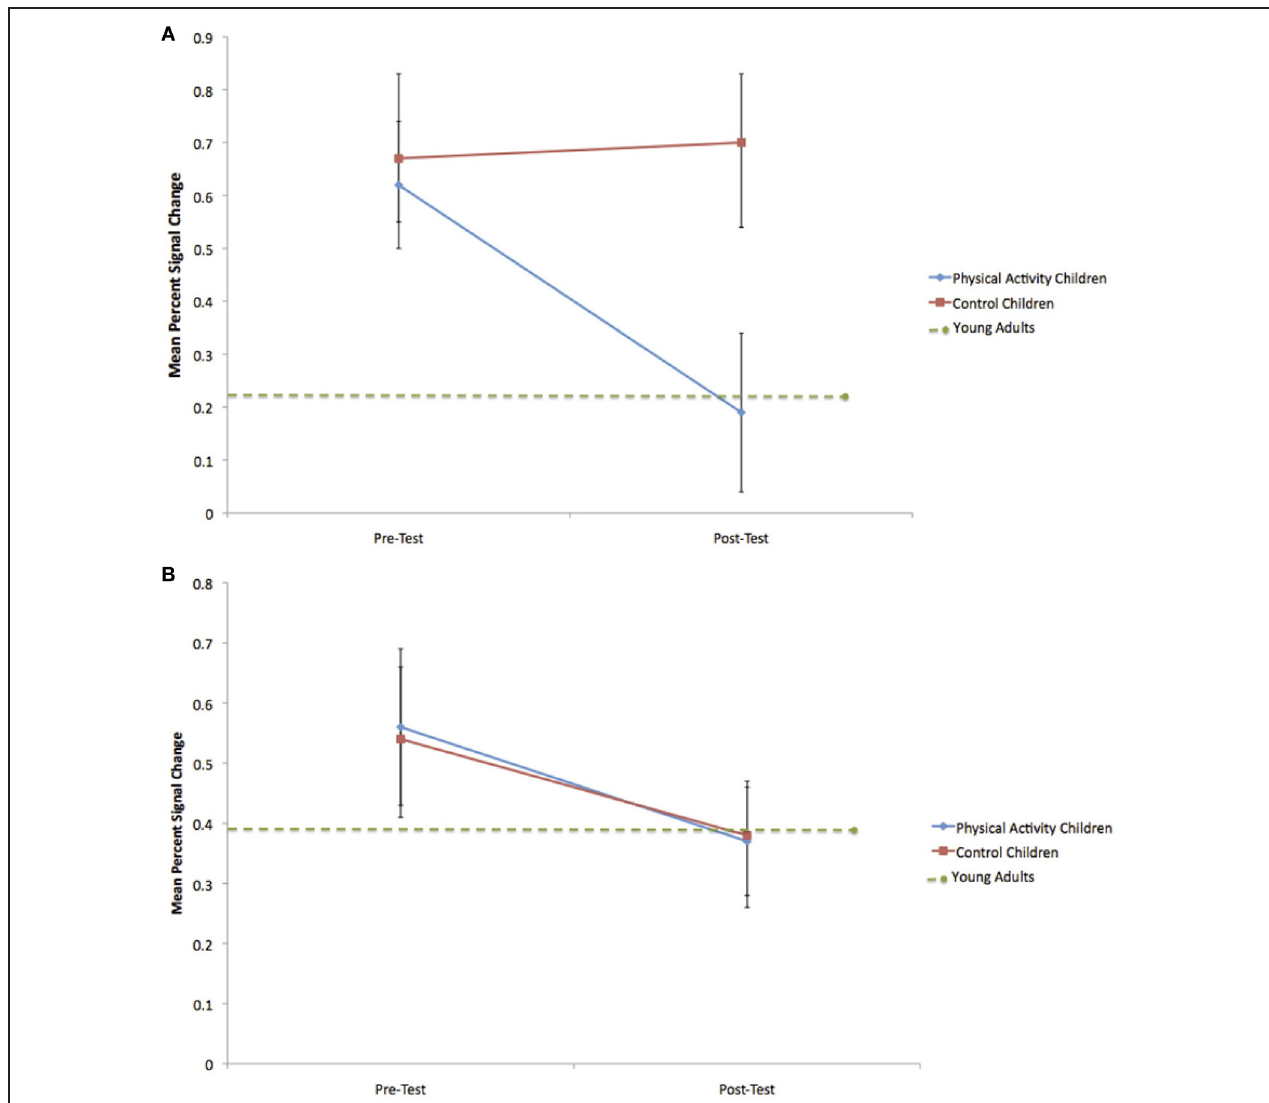
FIGURE 4 | (A) Change in mean percent signal change in the right anterior prefrontal cortex during incongruent flanker trials for the physical activity intervention group and wait-list control group. Error bars represent standard error. The decrease in activation for the physical activity intervention group led to mean percent signal change at